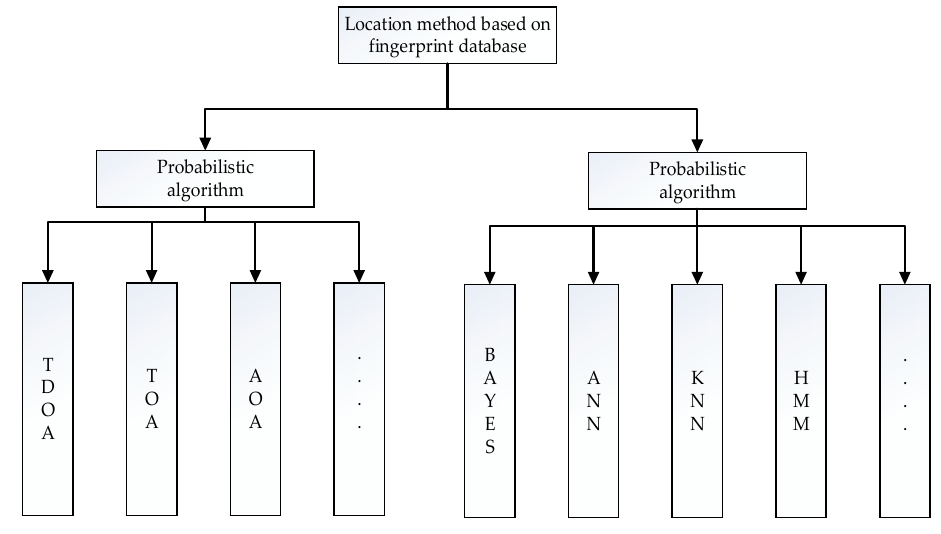
Figure 1. Deterministic positioning method and probabilistic positioning method.